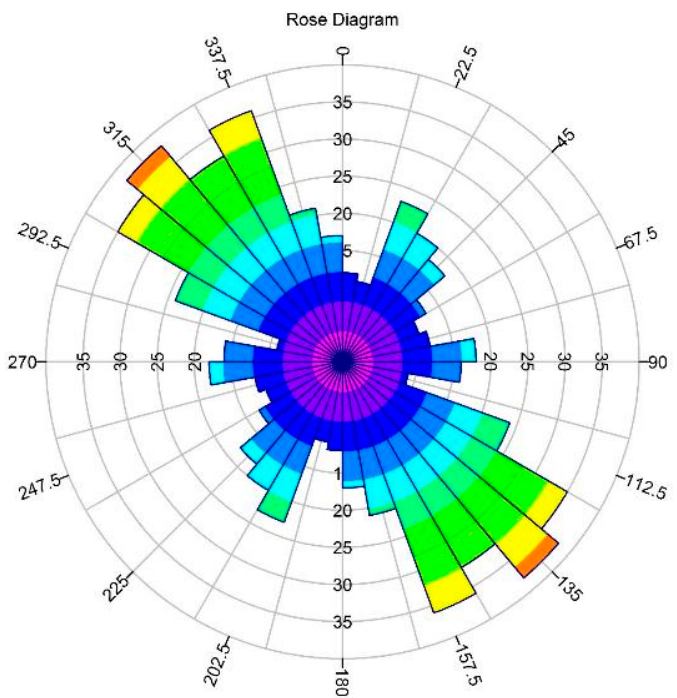
Figure 2. Generalized Rose Plot showing trends of joints on exposed rock surfaces in the study area. Each petal displays gradational colors, cold (purples, blues) to hot (oranges, reds).